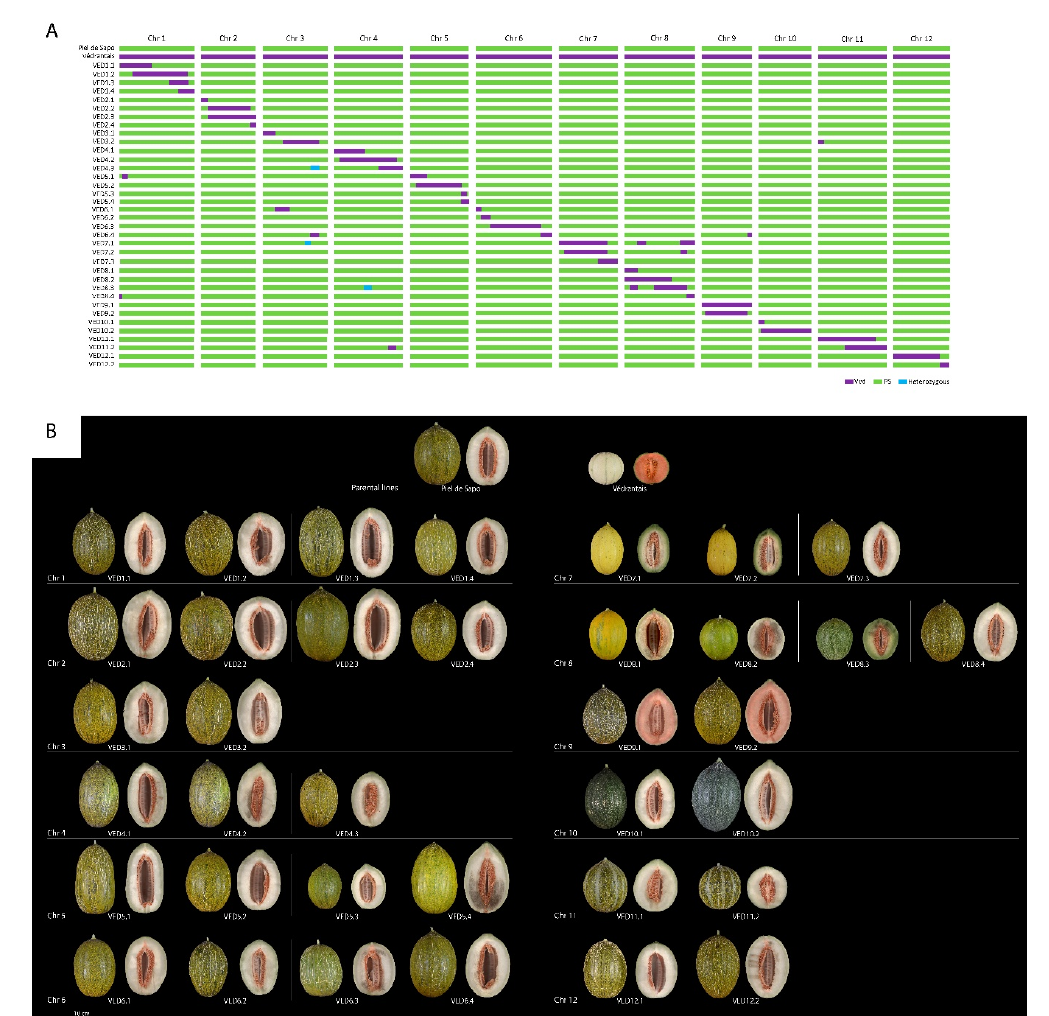
Figure 3. ( A ) Graphical representation of the genotypes of the introgression lines and the two parental lines. ( B ) External and internal appearance of each of the introgression lines and the parental lines.